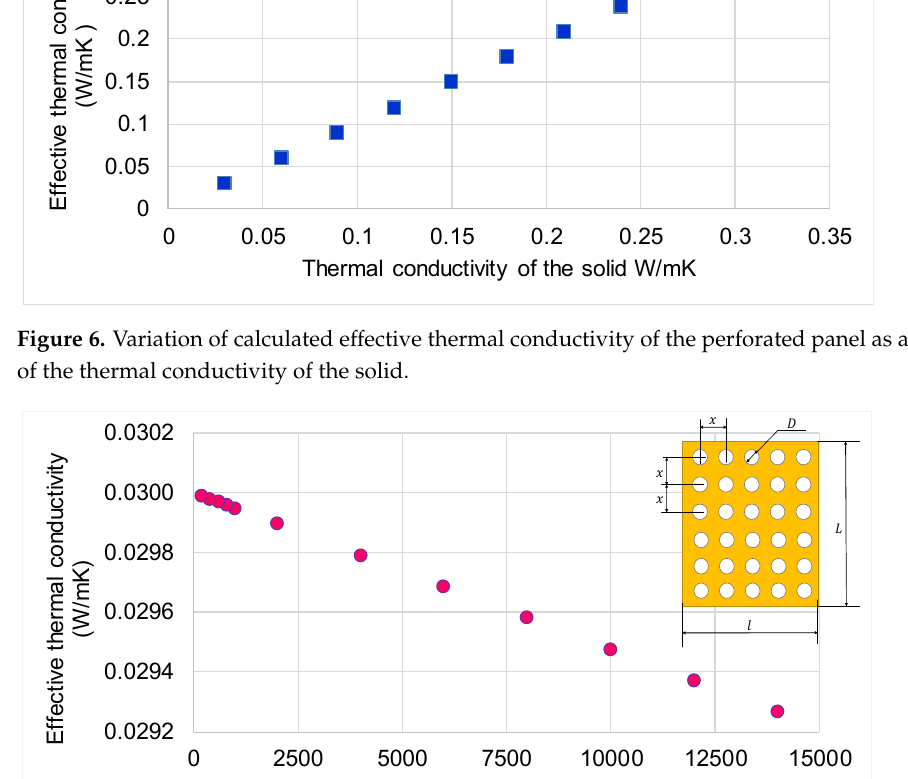
Figure 8. Variation of calculated effective thermal conductivity of the perforated panel as a function of the diameter of the channels. Legend: n —number of channels.